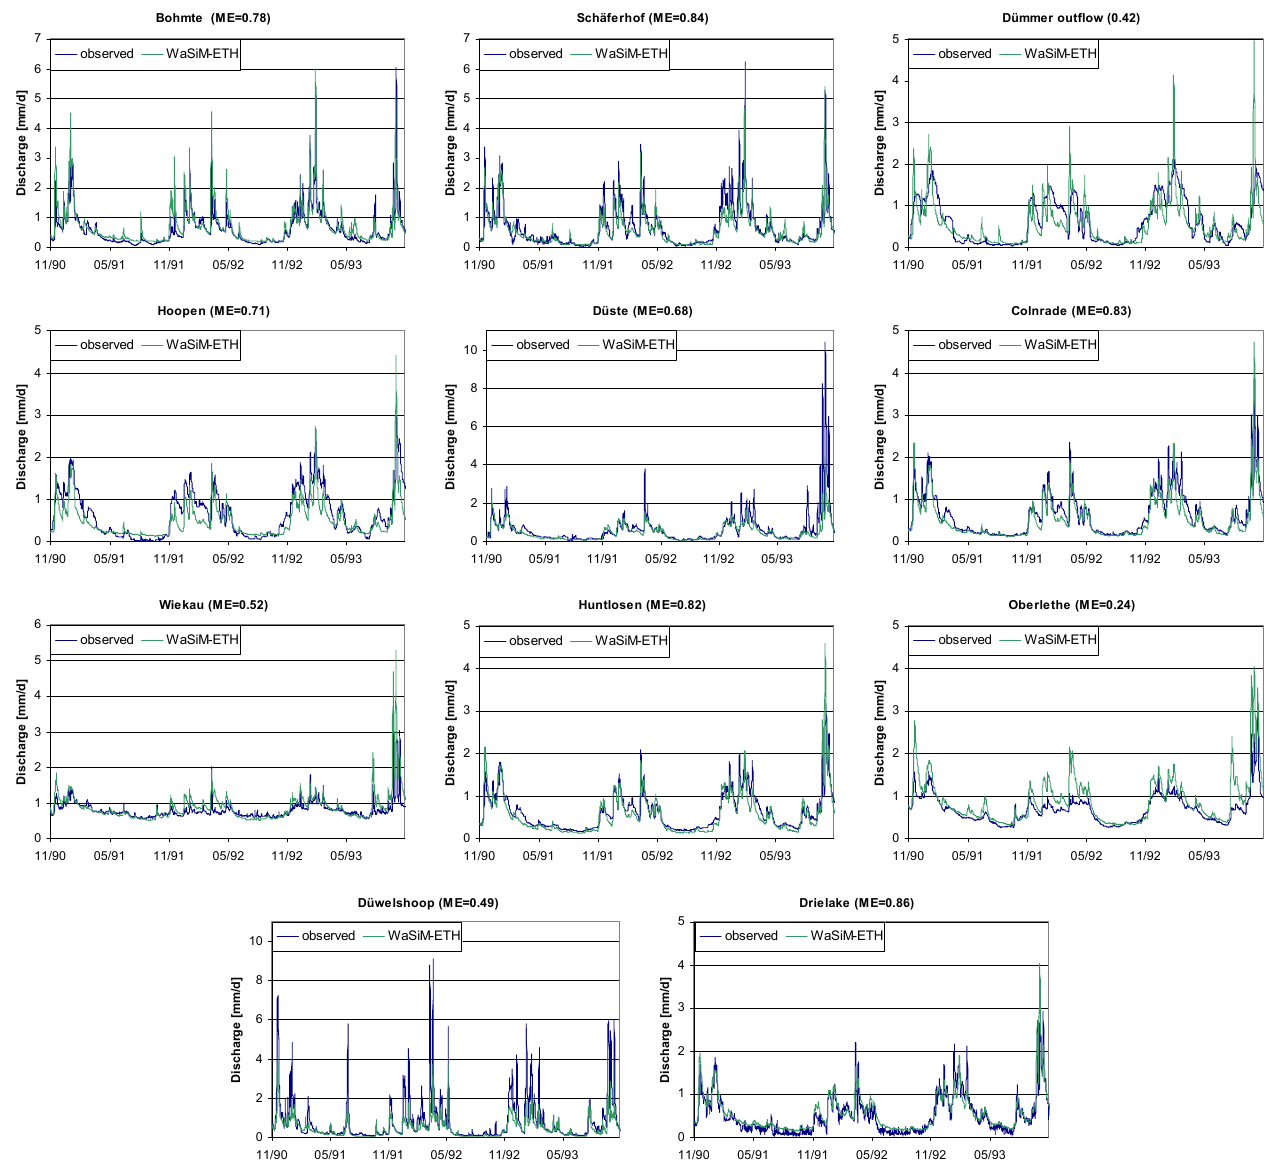
Fig. 3. Observed versus simulated discharges in the calibration period for the Hunte river at Oldenburg-Drielake and the 10subcatchments Figure 3: observed versus simulated discharges in the calibration period for the (ME=model efficiency for the entire calibration Hunte river at Oldenburg-Drielake and the 10 subcatchments (ME=model efficiency for the entire calibration period).